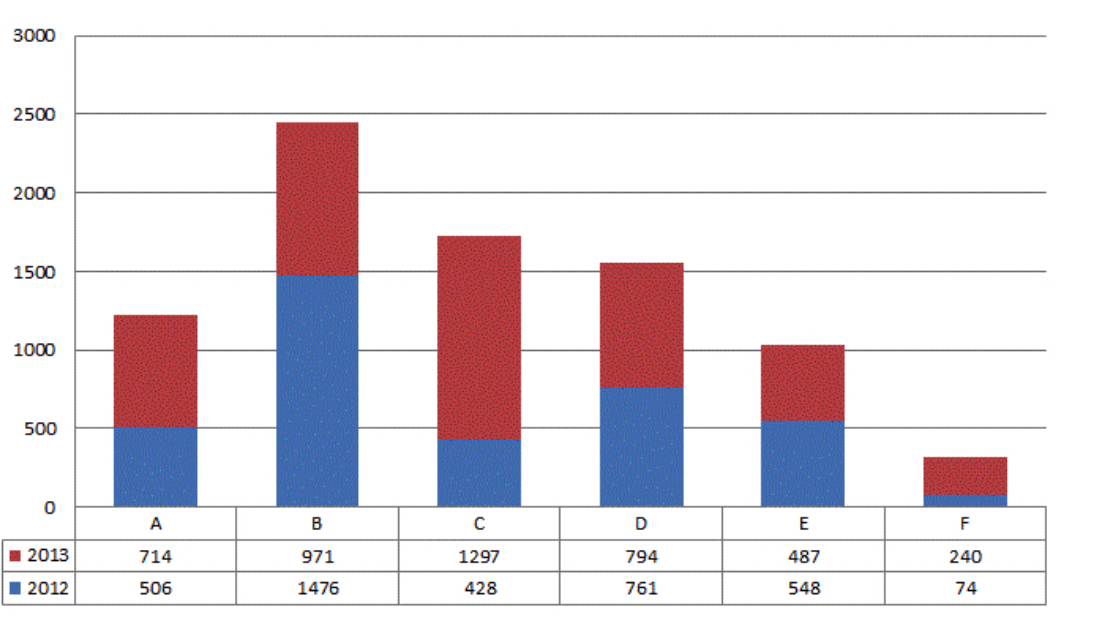
Figure 1. Number of new patients enrolled, by medical practice.